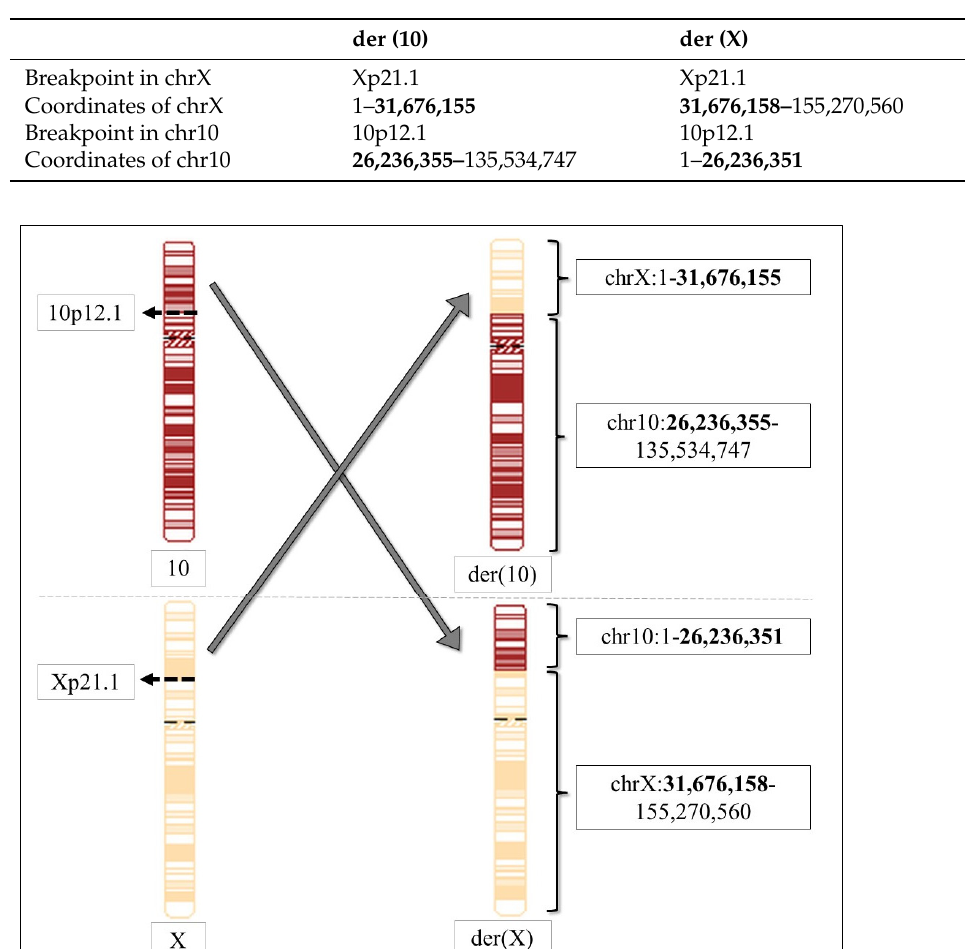
Figure 3. Schematic illustration of the t(X;10)(p21.1;p12.1) balanced reciprocal chromosomal translocation. Breakpoints are shown in bold. The presence of split reads aligned to the breakpoints can be seen in Figure 4. Part A shows the reads from WGS data. The first part of the sequence of these reads is comple- mentary with the sequence of the DMD gene on chromosome X, whereas the other part of the sequence can be aligned to the MYO3A gene on chromosome 10. After detecting the split reads in the WGS data, we retrospectively checked the position of the breakpoint in the targeted DMD sequencing data as well, where the coverage is higher and indeed, the presence of the split reads could also be detected in a higher number, as seen in part B of Figure 4.